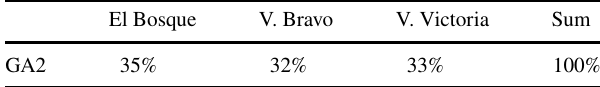
Fig. 5 The optimized Z curve found with genetic algorithm GA2 Table 4 Percentage of the total annual extraction supplied by each reservoir, found with genetic algorithm GA2 El